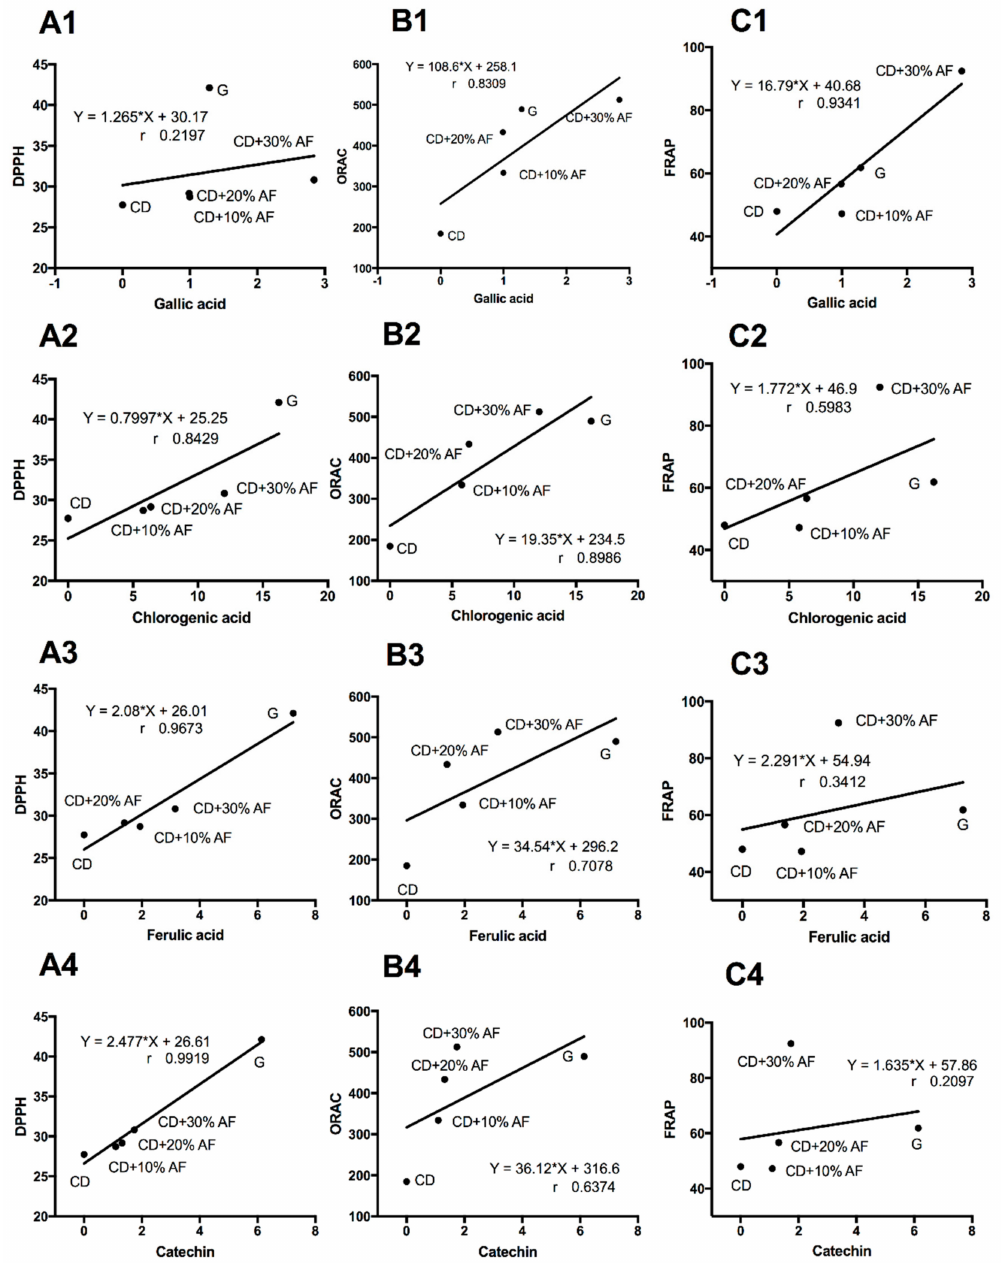
Figure 4. Pearson correlations among antioxidant activity and bioactive compounds concentrations from goat’s milk fed under grazing system (G), conventional diet (CD), or CD supplemented with di ff erent levels (10%, 20%, and 30%) of Acacia farnesiana pods (AF). DPPH • scavenging capacity assay ( A1 – A4 ). Oxygen radical absorbance capacity (ORAC) assay ( B1 – B4 ) and ferric-reducing